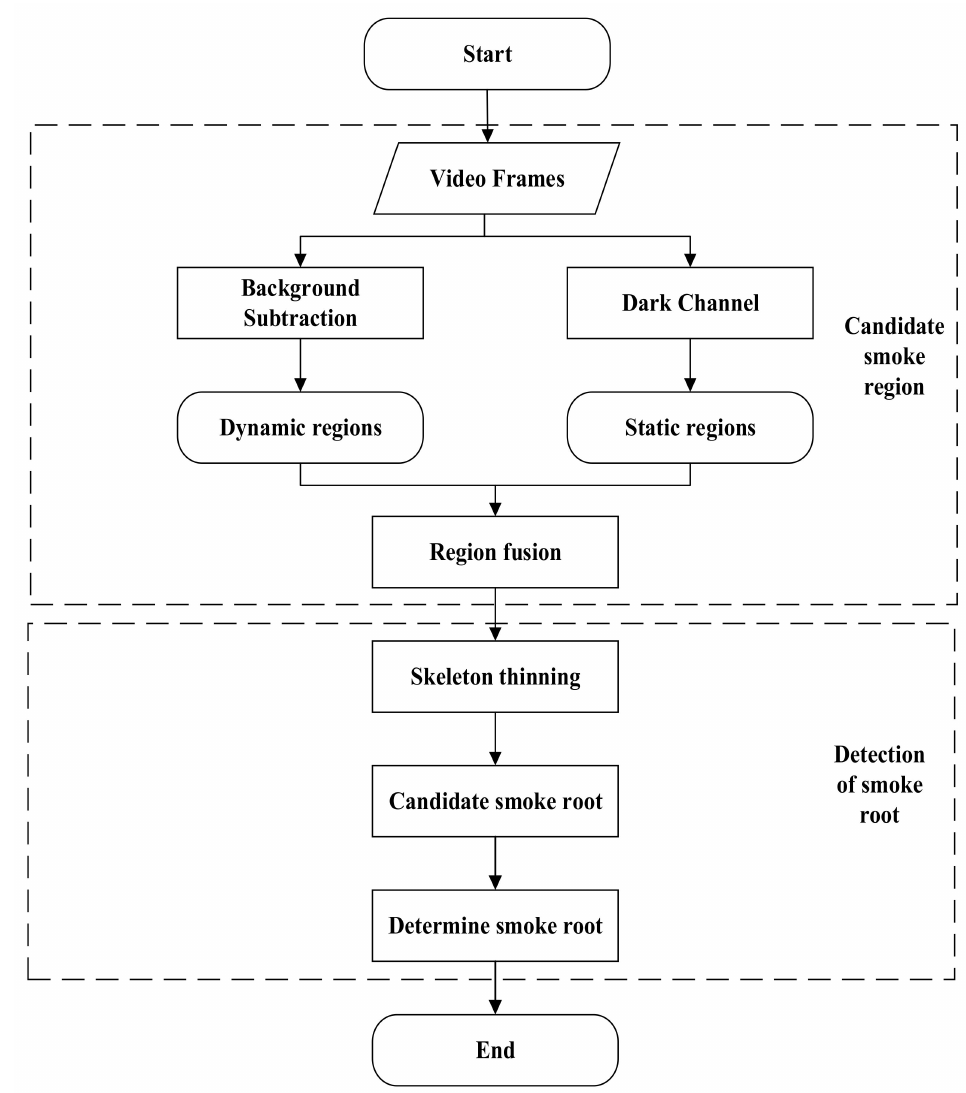
Figure 1. Flowchart of the proposed smoke root detection